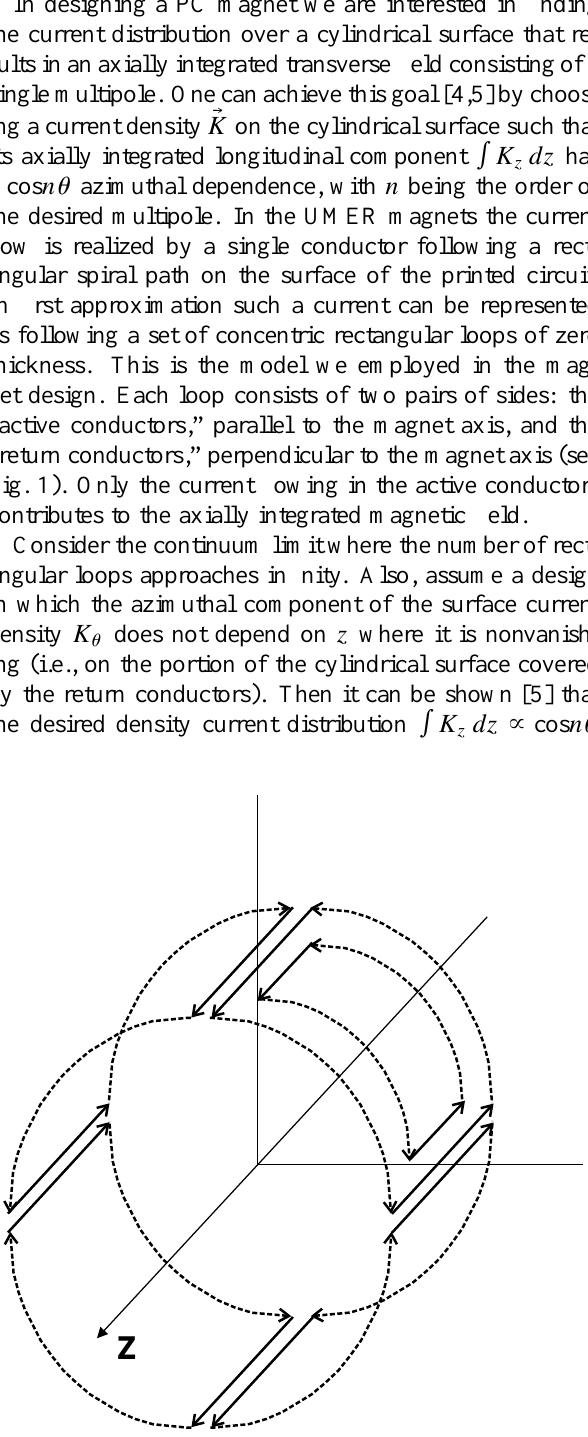
FIG. 1. Basic geometry of conductor layout for modeling printed-circuit magnets. The “active” conductors are shown as solid lines parallel to the beam axis ( z axis). The curved dotted lines are the “return” conductors. Current flow is indicated by the arrows.